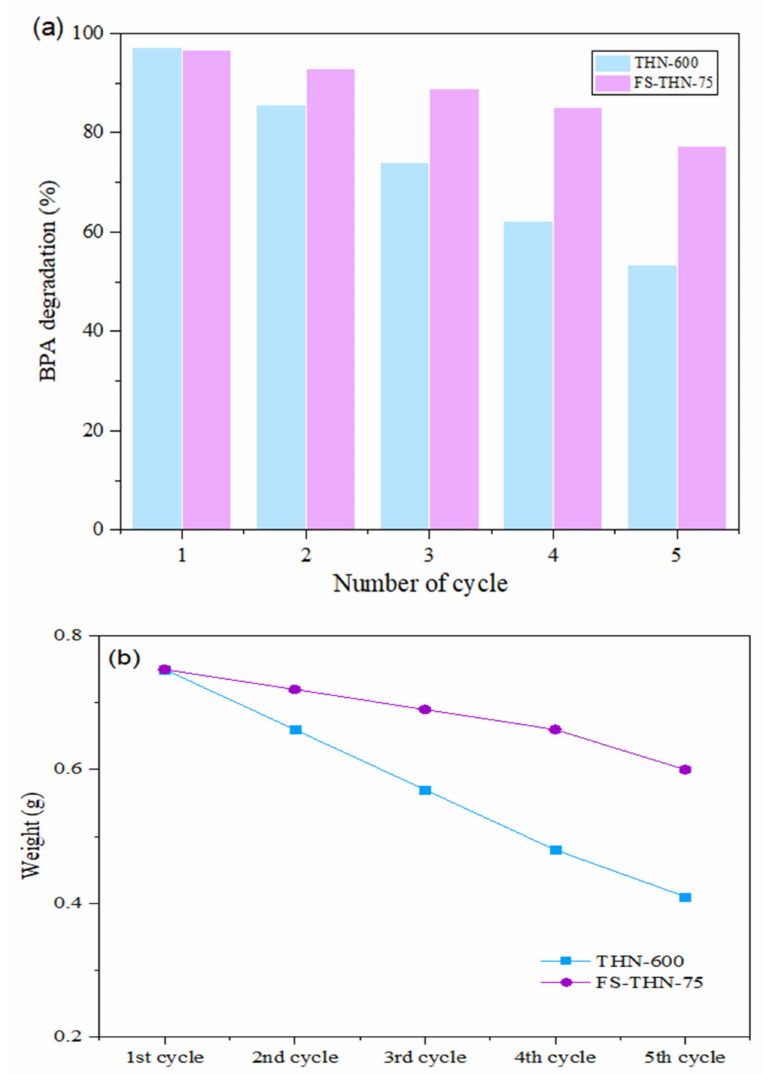
Figure 10. ( a ) Recyclability of THN-600 and FS-THN-75 at five cycles of reaction; ( b ) Corresponding weight of remaining catalysts.